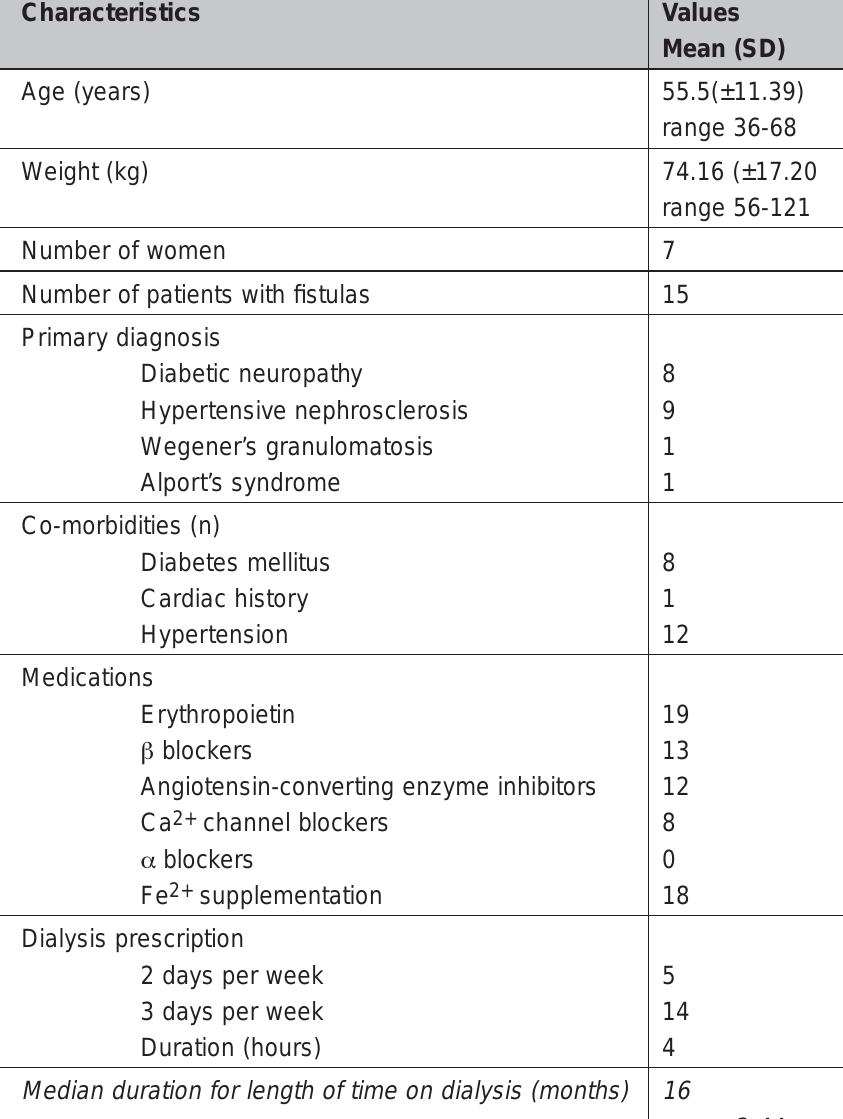
Table 1: Demographics profile of study population (n =